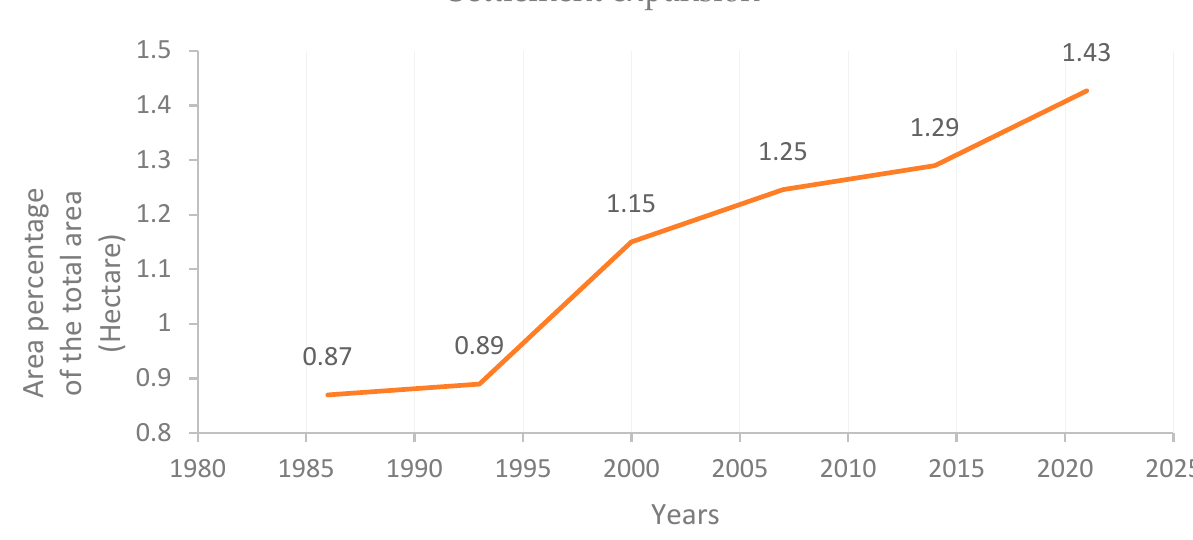
Figure 4. Settlement area changes between 1986 and 2021, as a percentage of the total area. Figure 5 shows a sample of settlement expansion in eMbalenhle township from 1986 to 2021. There are many settlements within the catchment, with differing rates of expansion during the study